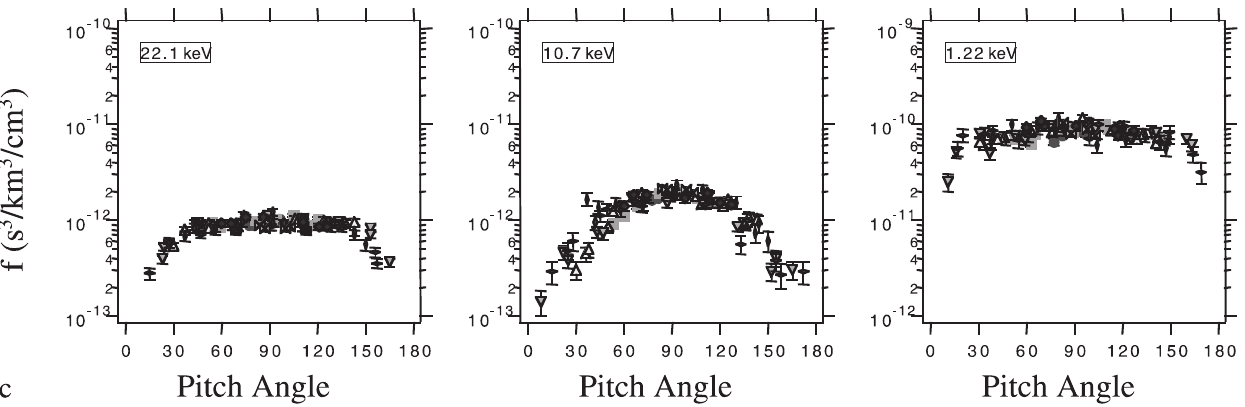
respect to the spin axis in the instrument. c Pitch angle distributions at three di(cid:128)erent energies for H + at L = 4.0–4.5. The di(cid:128)erent symbols represent di(cid:128)erent look directions with